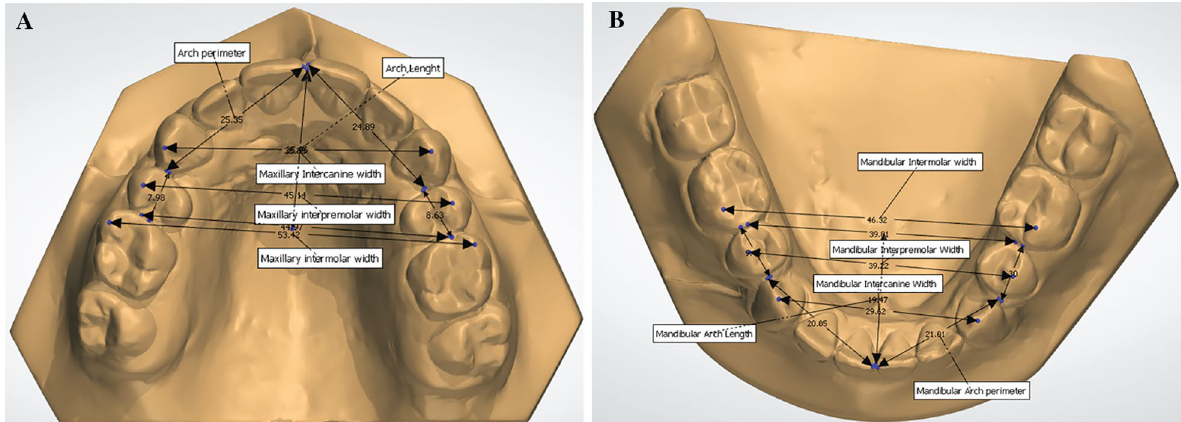
Fig. 2 A Measurements of maxillary transversal and longitudinal widths. B Measurements of mandibular transversal and longitudinal